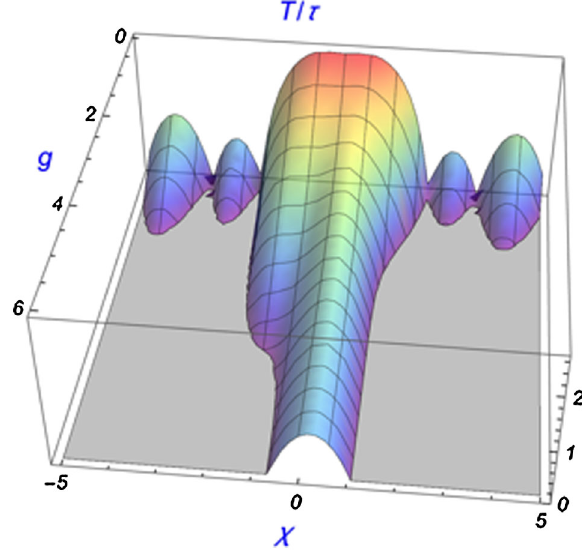
FIG. 10. Growth rate for the round chamber and resistive damper for w ¼ 8 (twice above the TMCI threshold). Seas of stability are huge.